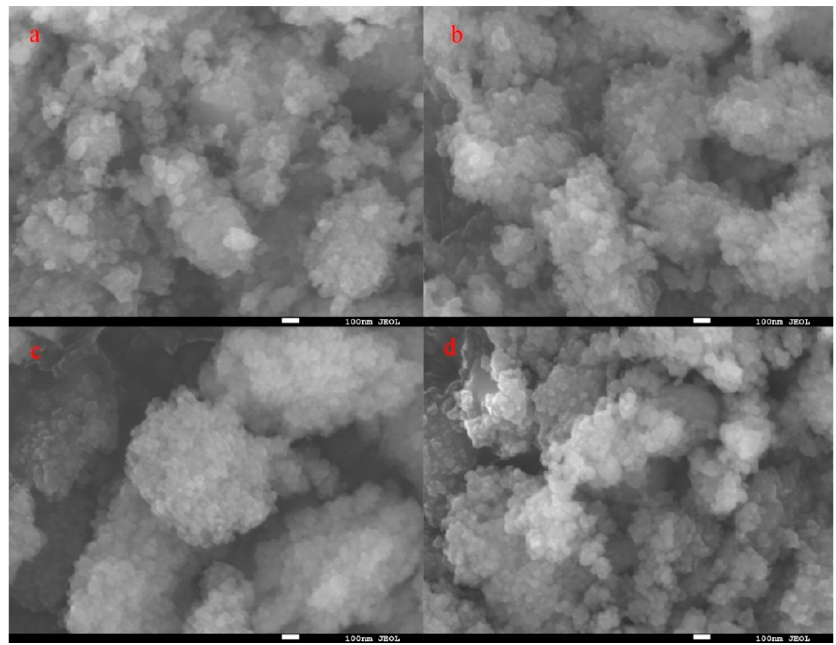
Figure 2. SEM images of the HZSM-5 catalysts with di ff erent Na / Al ratios in synthesis gels. ( a ) HZ(0), ( b ) HZ(0.4), ( c ) HZ(0.8), and ( d )